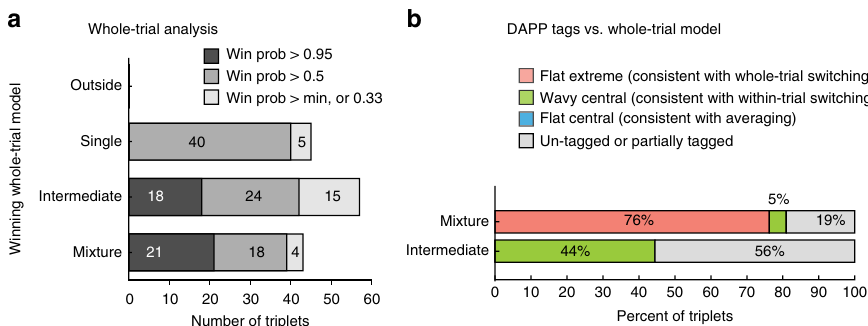
Fig. 6 Evidence of fl uctuations in face patch MF. a Population results of whole-trial analysis. As in Fig. 2i, shading indicates the con fi dence level of the assignment of individual triplets to winning models. b Population results of DAPP analysis by winning model from whole-trial analysis (win probability > 0.95). Results resemble those found in the IC, except that there was no evidence of Flat-Central among the Intermediates; Wavy-Central was